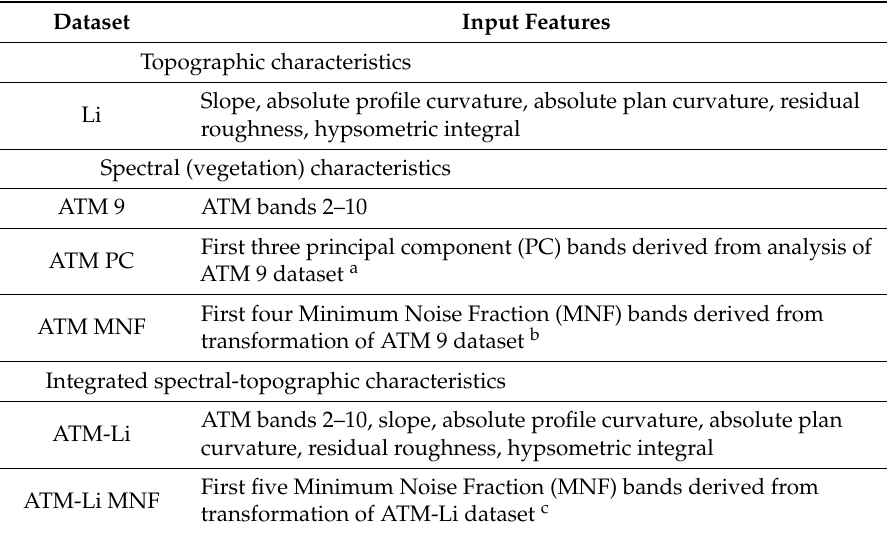
Table 2. Summary of the sets of input features used in the OBIA